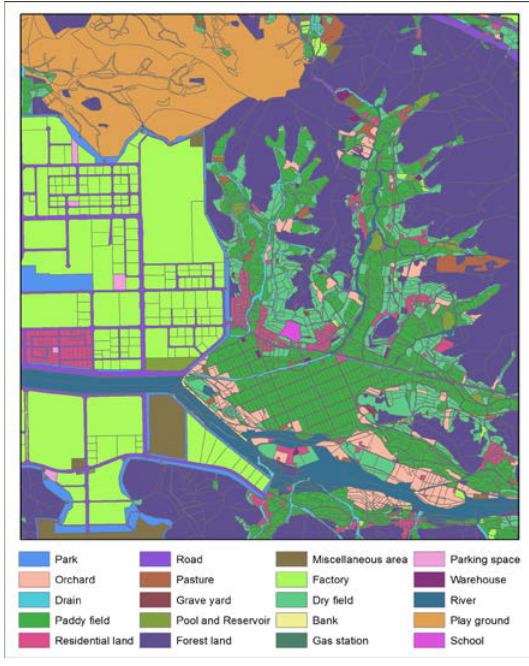
Figure 6. Cadastral map of the study